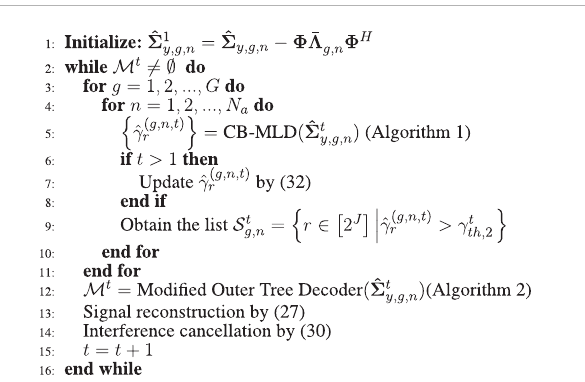
ALGORITHM 3 | Iterative Receiver for Common